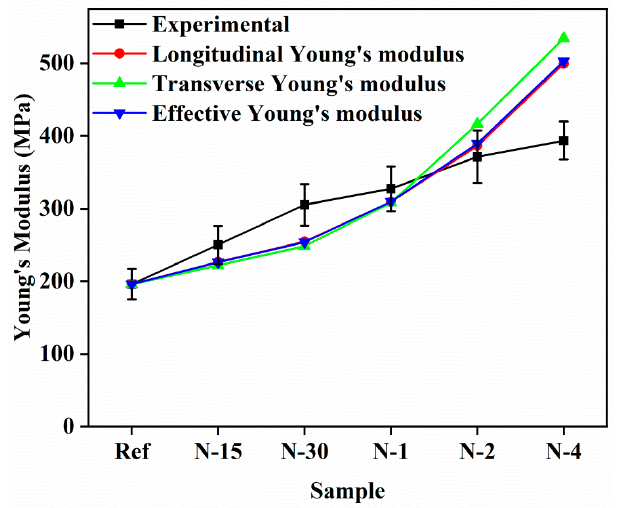
Figure 7. Comparison between the theoretical modeling results and experimental results for E c for the nanofiber-reinforced nanocomposites using the Hui–Shia model.